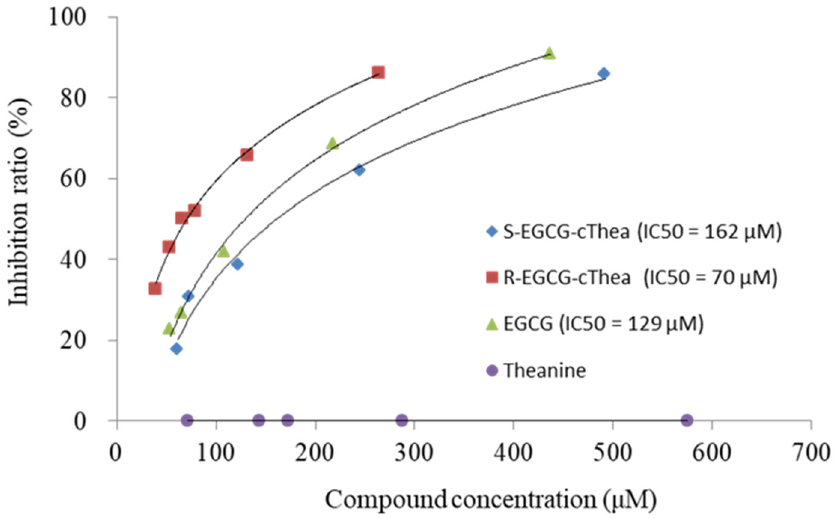
Figure 4. Dose-response inhibition curves and IC 50 of EGCG, theanine, S -EGCG-cThea, and R - EGCG-cThea against α